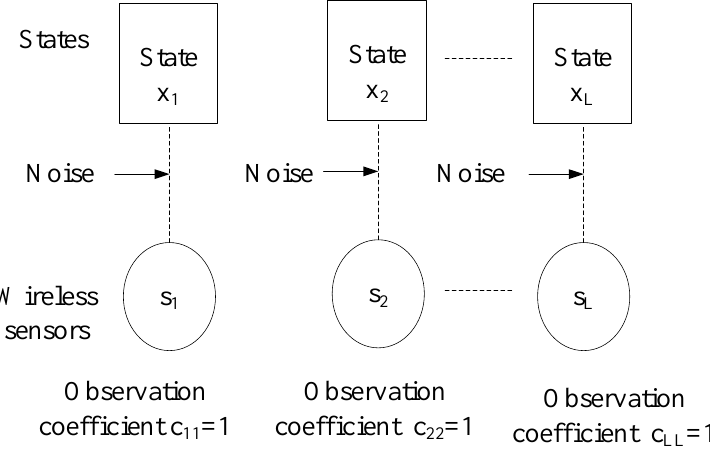
Figure 8. The bipartite graph for one sensor that can sense one system state